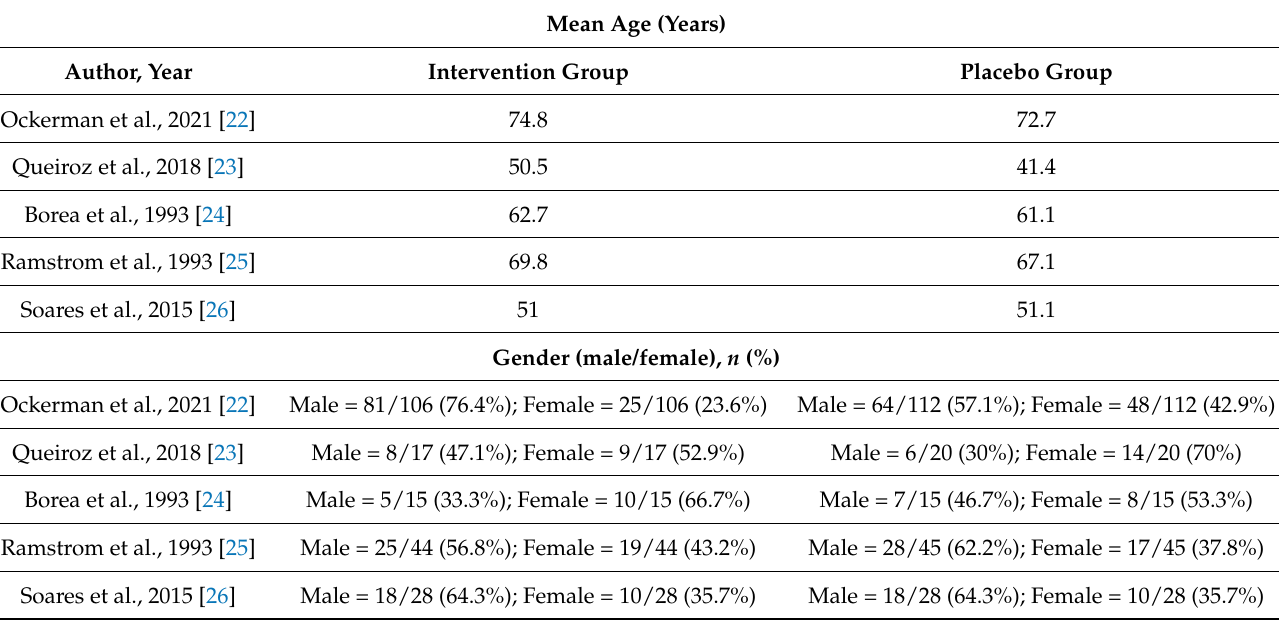
Table 1. Characteristics of included randomized controlled